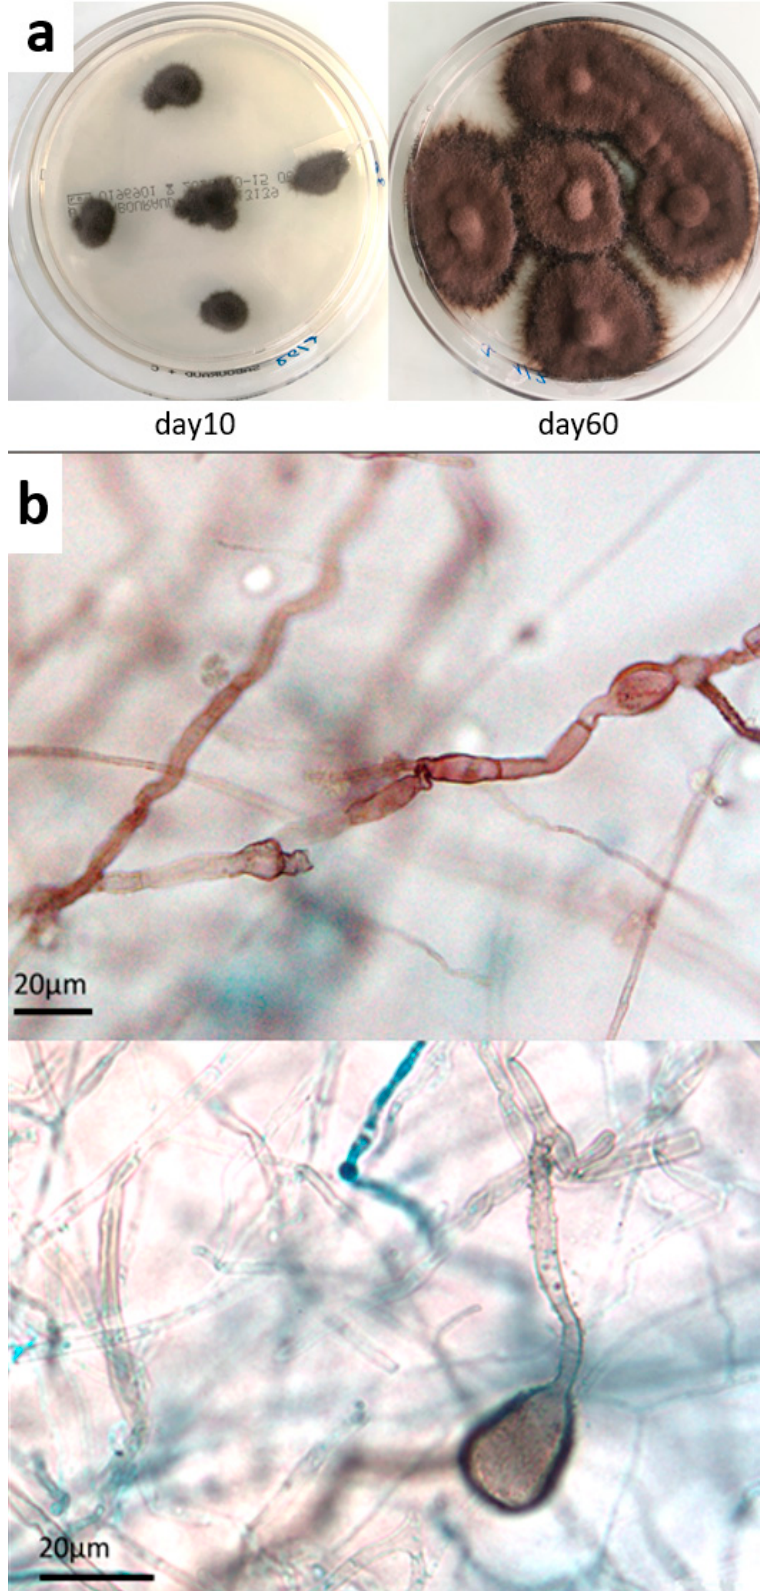
Figure 3. Mycological culture of skin biopsy. ( a ) Colonies obtained on Sabouraud chloramphenicol plates after incubation at 27 °C for 10 and 60 days. ( b ) Microscopic appearance of fungal colonies, showing dark sterile hyphae with swellings and cell-wall ornamentations (magnification ×500, ×1000, respectively).